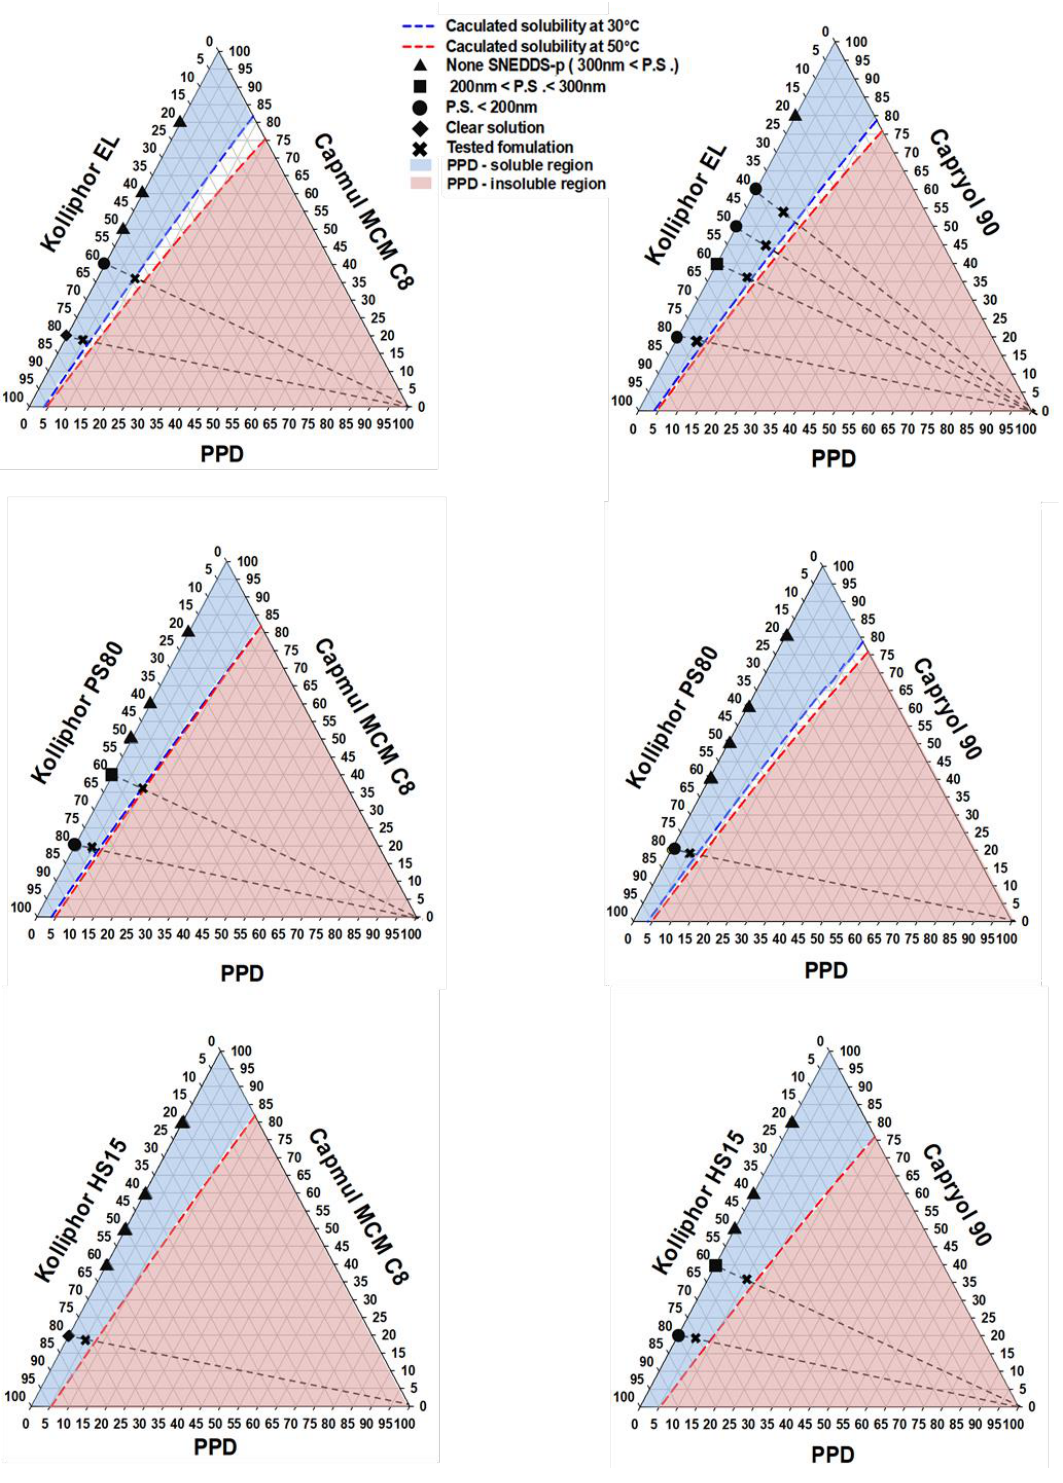
Figure 3. Selection of PSP formulations using comprehensive ternary phase diagrams; None SNEDDS-p, none self-nanoemulsifying drug delivery system preconcentrate; P.S., particle size.